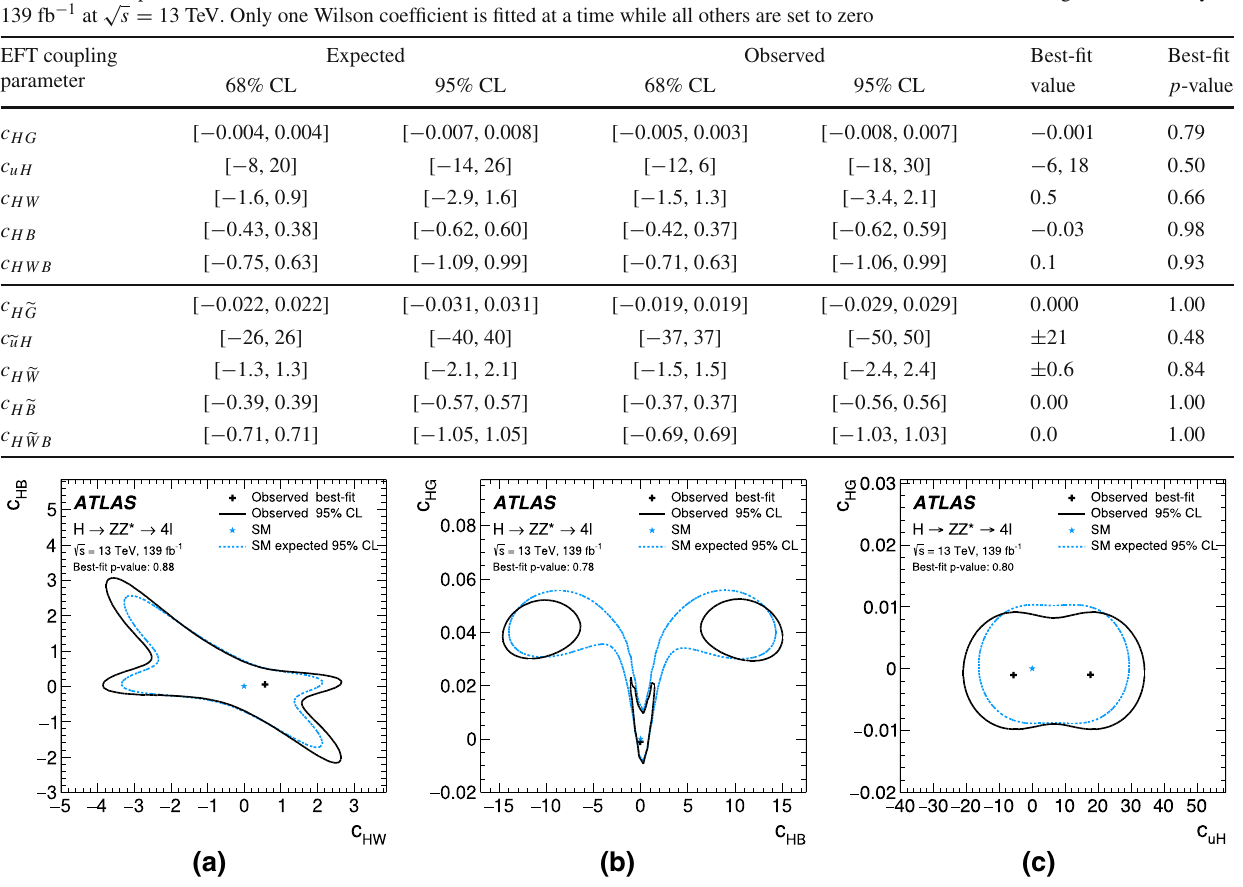
√ s = 13TeV.Thebestfittothedata(solidcross)andtheSMprediction (star) are also indicated. Except for the two fitted Wilson coefficients, all others are set to zero